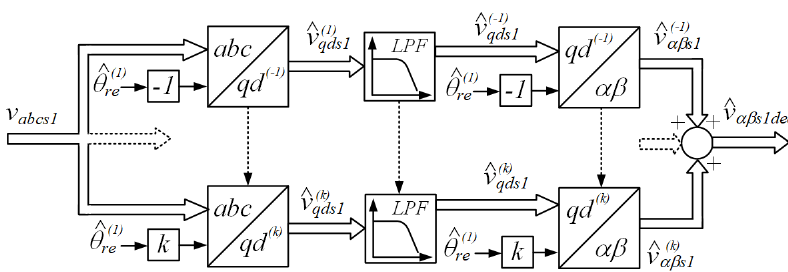
Figure 4. Block diagram of the multiharmonic SRF filtering (MSF) algorithm.